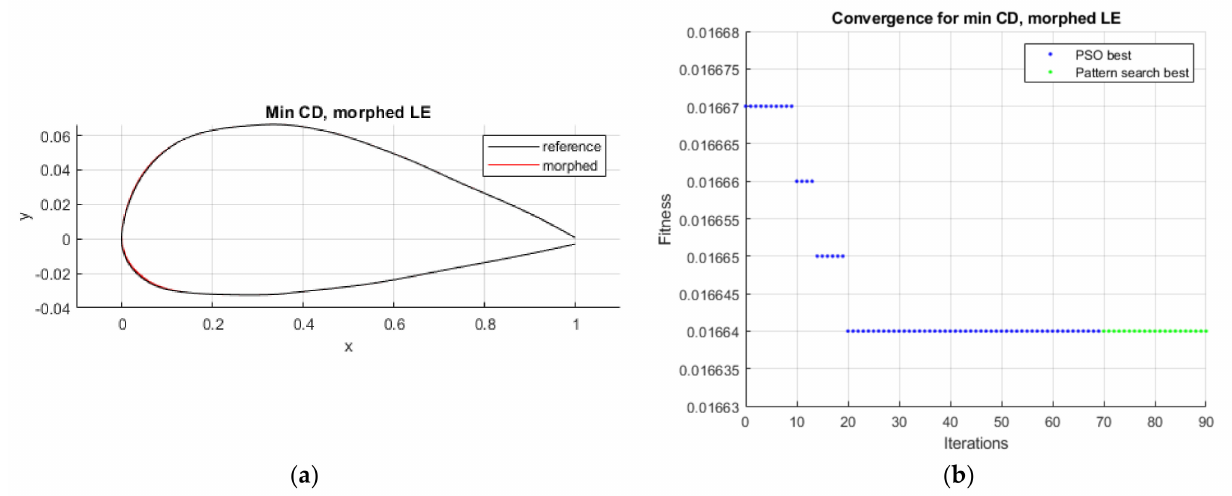
Figure 12. Optimized airfoil and convergence history for drag minimization function; ( a ) the initial (reference) versus the final (optimized or morphed) airfoil shape, ( b ) the convergence trend for the minimum drag optimization